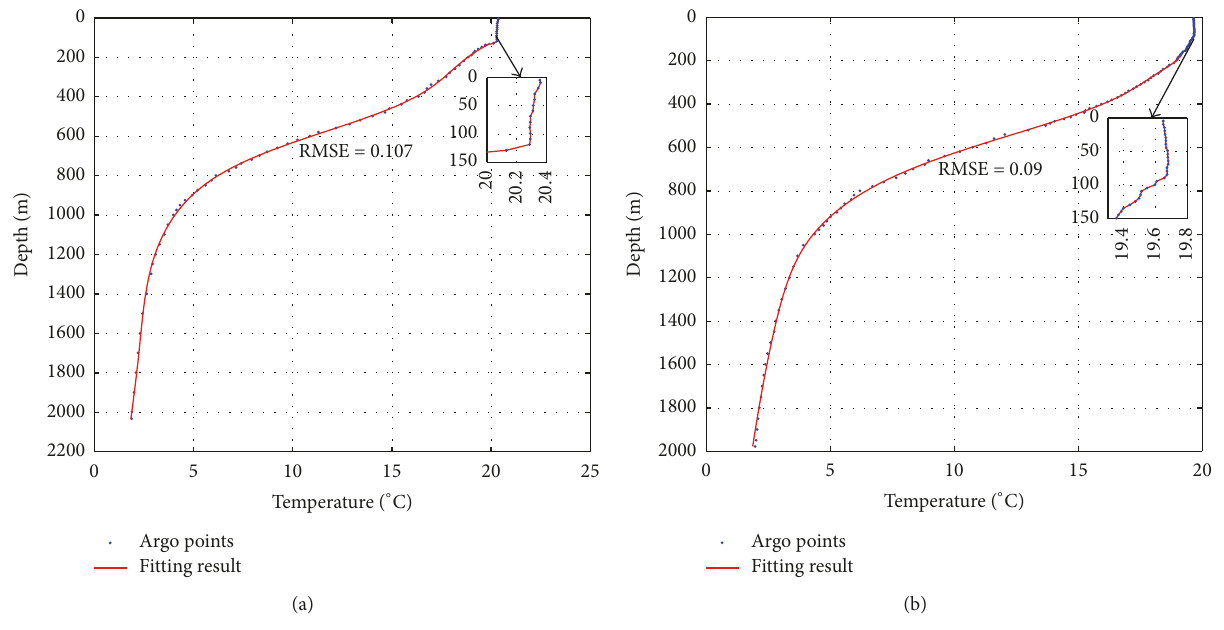
Figure 3: Fitting result of Argo profile, platform, and cycle number: 2900715 162 (a) and 2900683 110 (b).